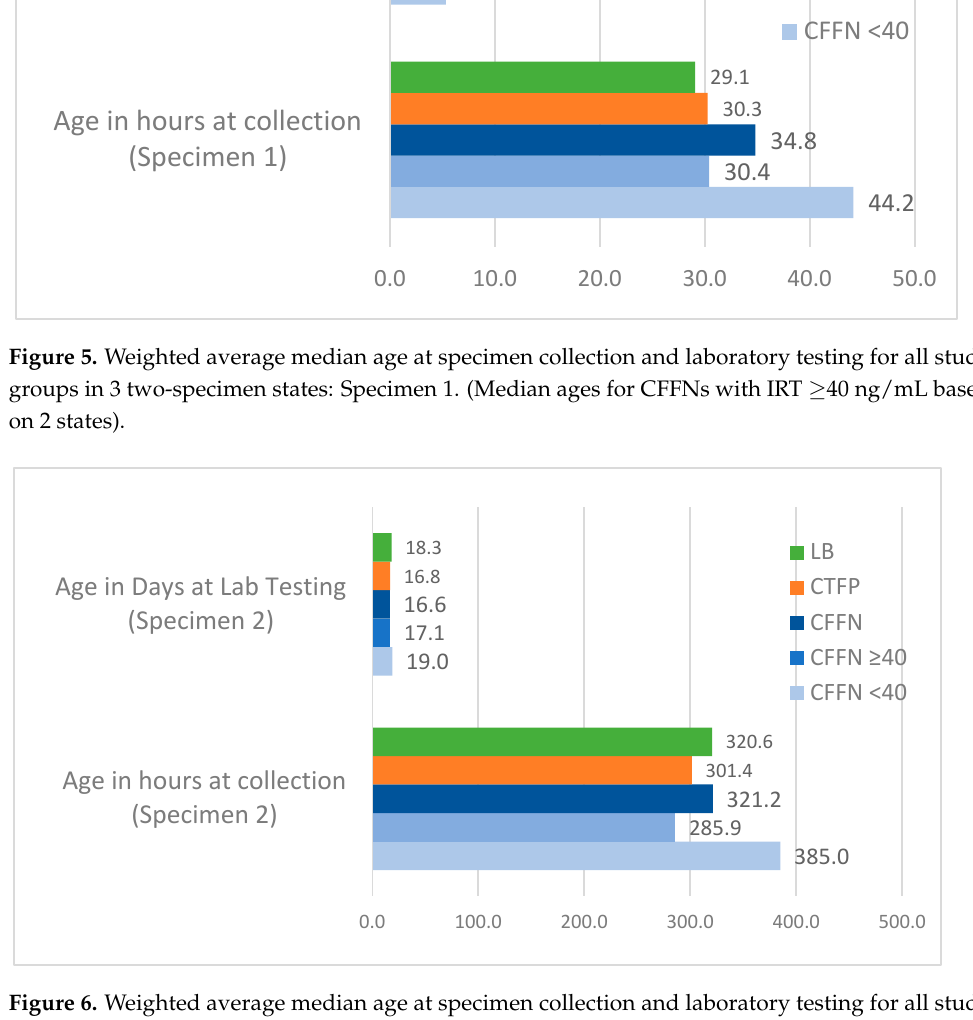
Figure 6. Weighted average median age at specimen collection and laboratory testing for all study groups in 3 two-specimen states: Specimen 2. (Median ages for CFFNs with IRT ≥ 40 ng/mL based on 2 states).